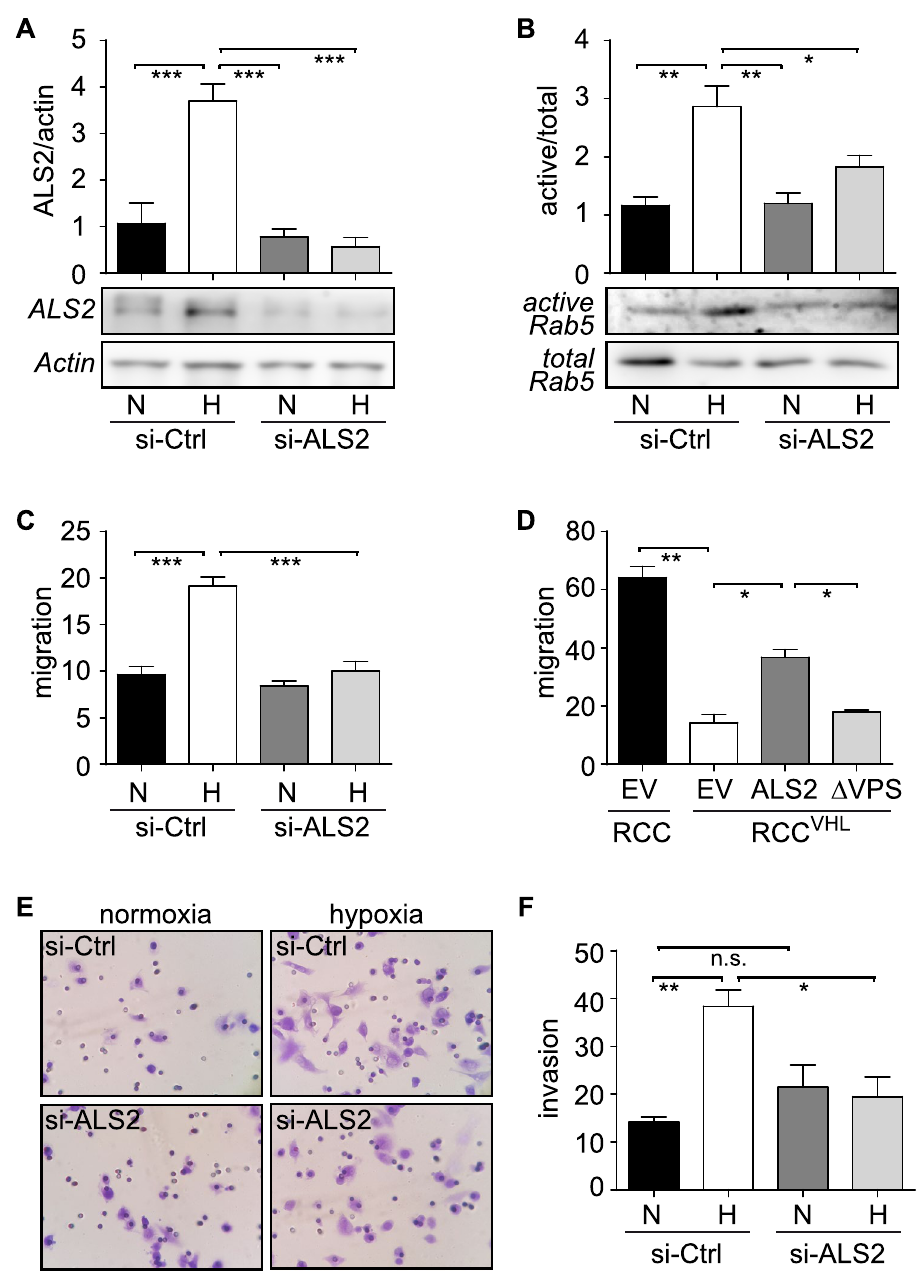
Figure 3. ALS2 is required for hypoxia induced Rab5 activity, tumor cell migration and invasion. ( A – C ) A549 cells were transfected with control (si-Ctrl) or ALS2 (si-ALS2) targeting siRNA constructs, exposed to normoxia (N) or hypoxia (H) for 24 h and used for subsequent analysis. (A) Whole cell lysates were prepared and analyzed by Western blotting with antibodies against ALS2 and actin. Representative images are shown and relative levels of ALS2 were quantified by scanning densitometry and normalized to actin. Graph represents the average from 3 independent experiments (mean ± SEM; *** p < 0.001). ( B ) Rab5-GTP levels were measured by R5BD pulldown assays. Lower panel, representative Western blot images of GTP-bound active Rab5 and total Rab5, respectively. Upper graph shows the average from 3 independent experiments, obtained by scanning densitometry analysis of active Rab5 and normalized with respect to total Rab5 (mean ± SEM; * p < 0.05; ** p < 0.01). ( C ) Cell migration was assessed in Boyden Chambers, as previously standardized by us (for details, see materials and methods). Cells were allowed to migrate for 2 h in Transwell chambers, coated with 2 μg/ml fibronectin, under normoxic conditions. Cells that migrated were visualized by crystal violet staining. Data represent the average from 3 independent experiments (mean ± SEM; *** p < 0.001). ( D ) RCC4 and RCC4 +VHL cells were transfected for 24 h with either empty vector control (GFP), full-length ALS2 (GFP-ALS2 WT ) or VPS9-deficient ALS2 (ALS2 ΔVPS9 ). Cells were harvested and used for subsequent cell migration analysis. Data represent the average from 3 independent experiments (mean ± SEM; * p < 0.05). ( E , F ) A549 cells were transfected for 24 h with control or ALS2 targeting siRNA constructs, harvested, seeded onto Matrigel Chambers and allowed to invade in normoxia (N) or hypoxia (H) for 24 h. Representative images are shown. Graph represents the quantification of 3 independent experiments (mean ± SEM; * p < 0.05; ** p < 0.01; n.s.,